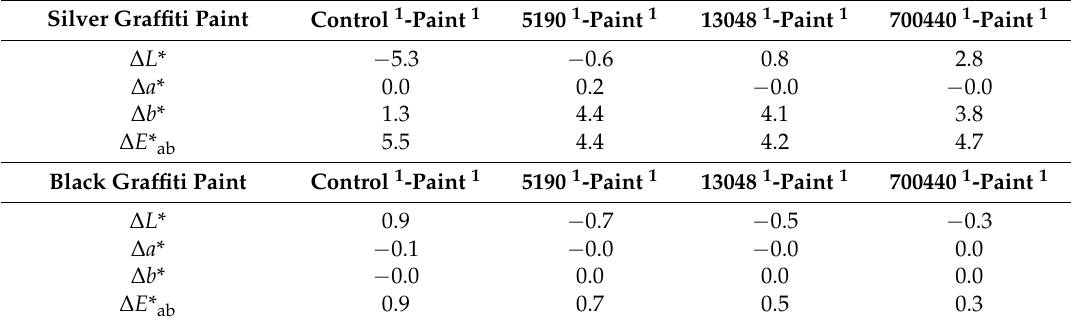
Table 3. Partial colour differences ( ∆ L *, ∆ a * and ∆ b *, CIELAB units) and total colour difference ( ∆ E ab , CIELAB units) between the painted specimens of man-made